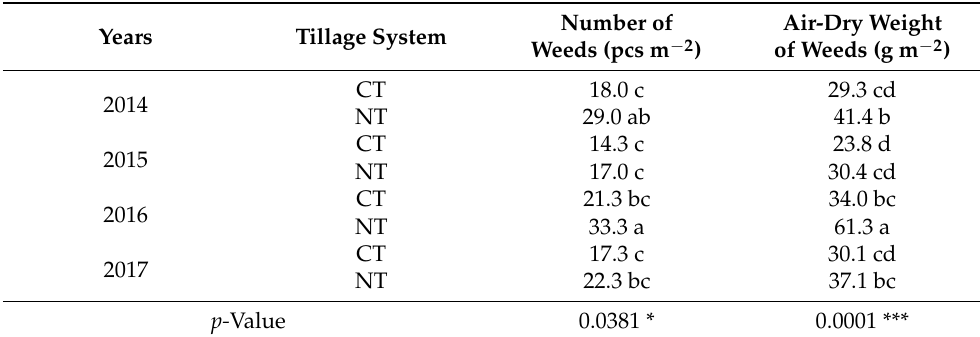
Table 7. Interactive dependencies of tillage systems and years of research in determining the number and weight of weeds in winter oilseed rape crop.